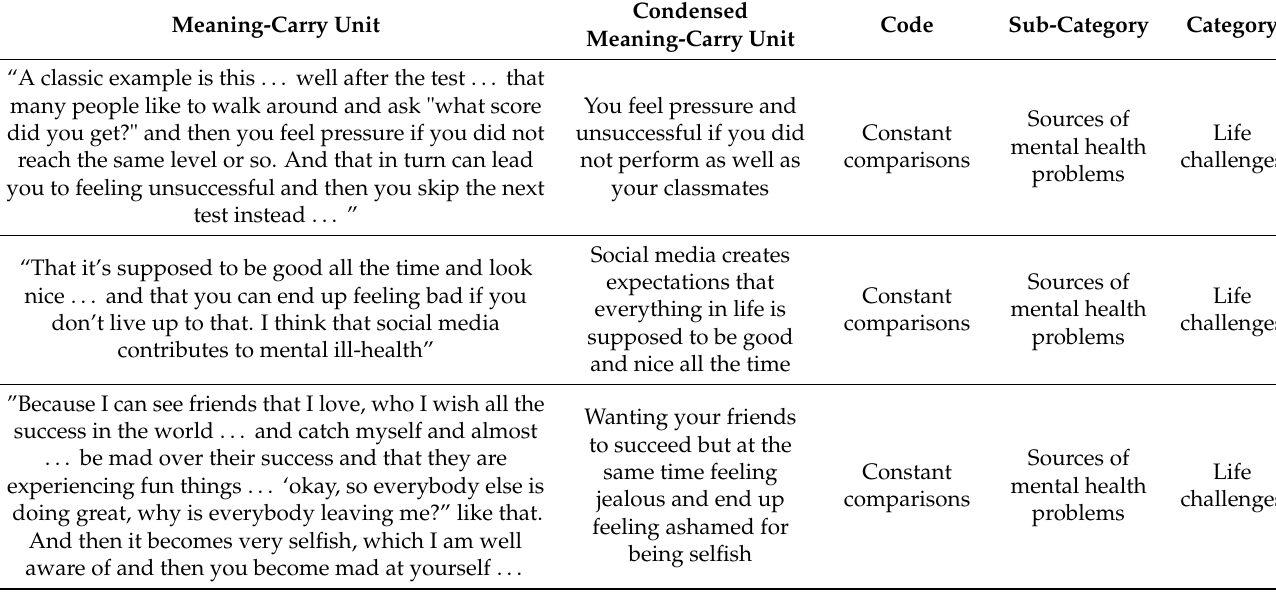
Table 1. Qualitative content analysis showing examples of adolescents’ and young adults’ views on mental health.